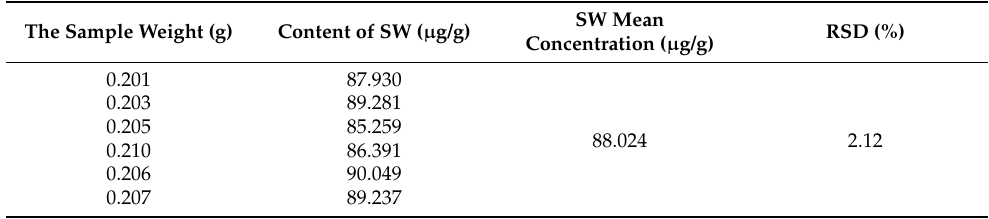
Table 2. Repetitive experiment results.